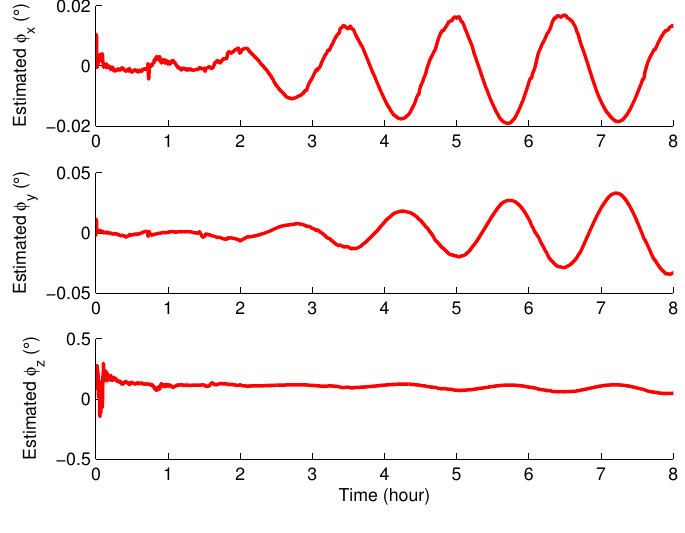
Figure 11. The estimated misalignment angles.